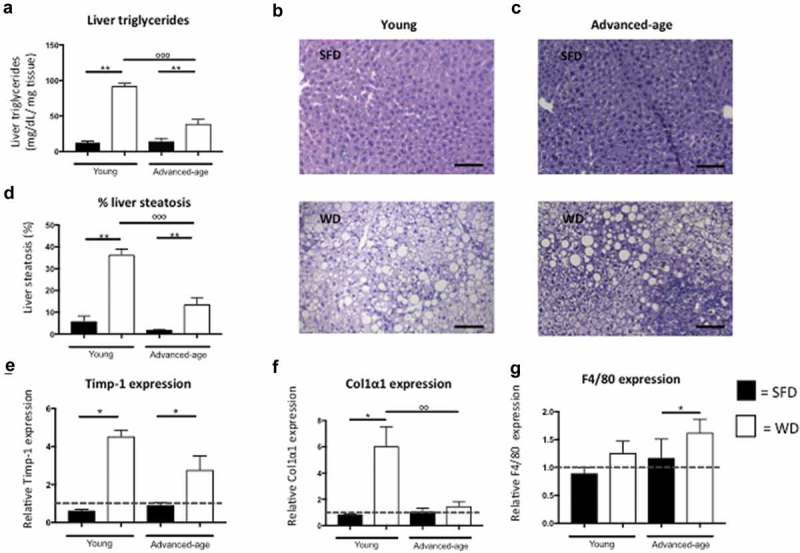
Increased hepatic steatosis but not fibrosis in advanced-age mice. (a) Hepatic triglyceride concentration (mg/dL/mg tissue) in young and advanced-age mice kept on either SFD (black) or WD (white) for 15 weeks. (b-c) H&E stained liver section of a young mouse kept on SFD (top) or WD (bottom) (B) and of an advanced-age mouse kept on SFD (top) or WD (bottom) for 15 weeks (C). Magnification is 200x and scale bar is 100 µm. (d) Quantification of H&E stained liver sections of young and advanced-age mice kept on SFD (black) or WD (white). (e-f) relative hepatic Timp-1 and Col1α1 expression in young and advanced-age mice kept on SFD (black) or WD (white). (g) relative hepatic F4/80 expression in young and advanced-age mice kept on SFD (black) or WD (white). * = p < 0.05 and ** = p < 0.01 in SFD vs WD. ° = p < 0.05, °° = p < 0.01 and °°° = p < 0.001 between young and advanced-age mice kept on the same diet. Fas = TNF receptor superfamily member 6, CD = cluster of differentiation, SFD = standard-fat diet, WD = western-type diet, Timp-1 = tissue inhibitor of matrix metalloproteinase-1, Col1α1 = collagen type 1 α 1.